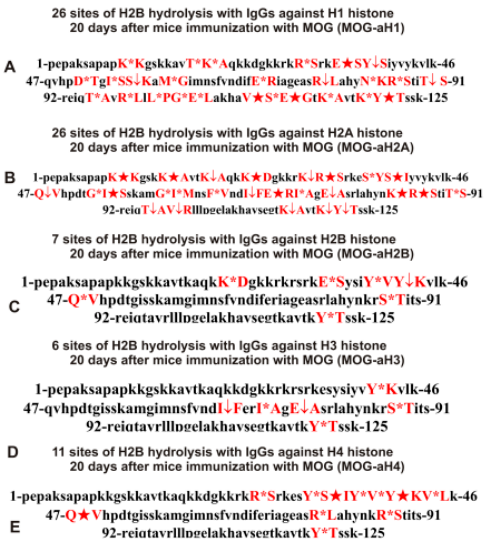
Figure 9. Sites of H2B hydrolysis by IgGs against five H1-H4 histones corresponding to 20 days after mouse immunization with MOG: MOG20-aH1 ( A ), MOG20-aH2A ( B ), MOG20-aH2B ( C ), MOG20-aH3 ( D ), and MOG20-aH4 ( E ). Major sites of H1 cleavage are shown by stars ( ★ ), moderate sites by arrows ( ↓ ), and minor sites of cleavage by small stars (*).